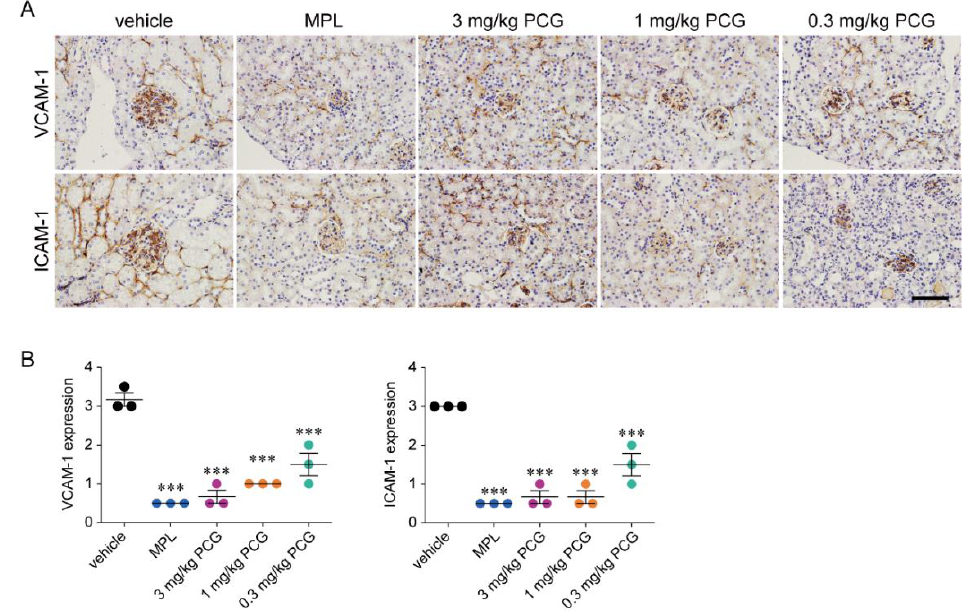
Figure 7. PCG suppresses the expression of VCAM-1 and ICAM-1 in kidney tissues of lupus prone mice. ( A ) Immunohistochemical staining of VCAM-1 and ICAM-1 in kidney tissues in NZB/W F1 mice at 30 weeks of age. Scale bar = 50 μm. ( B ) The intensity of VCAM-1 and ICAM-1 staining on glomeruli and tubules was assigned based on a 4-point scale (mean ± SEM, n = 4 – 8/group). *** p < 0.001 versus vehicle. Two- tailed Student’s t -test ( B ).